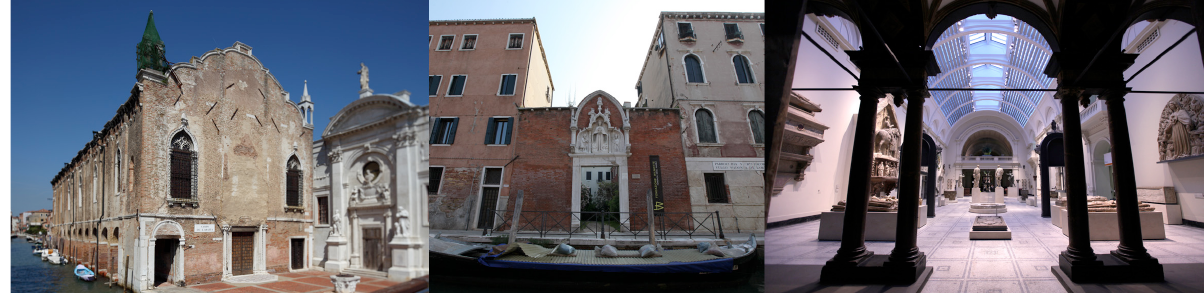
Figure 1: The façade of the Scuola della Misericordia , the XIV century removed portal in Venice and the bas-relief exposed at the